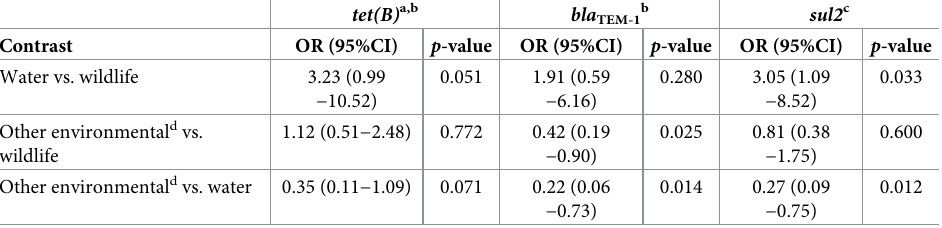
Table 6. Contrasts from logistic regression models a,b,c (Table 5) assessing the statistically significant associations between source type and the occurrence of select antimicrobial resistance genes in phenotypically resistant Escher- ichia coli isolates collected from wildlife, swine manure pits, and environmental sources in southern Ontario, 2011 − 2013 (n = 200, dataset A). tet(B) a,b bla TEM-1b sul2 c Contrast OR (95%CI) p -value OR (95%CI) p -value OR (95%CI) p -value Water vs. wildlife 3.23 (0.99 0.051 1.91 (0.59 0.280 3.05 (1.09 0.033 − 10.52) − 6.16) − 8.52) Other environmental d vs. 1.12 (0.51 − 2.48) 0.772 0.42 (0.19 0.025 0.81 (0.38 0.600 wildlife − 0.90) − 1.75) Other environmental d vs. water 0.35 (0.11 − 1.09) 0.071 0.22 (0.06 0.014 0.27 (0.09 0.012 − 0.73) − 0.75) a Adjusted for confounding by year of sampling. b Site of sampling was retained as a random intercept. c The random intercept to account for clustering by site or animal was not retained in the model, thus ordinary logistic regression was used. d Includes soil and dumpster